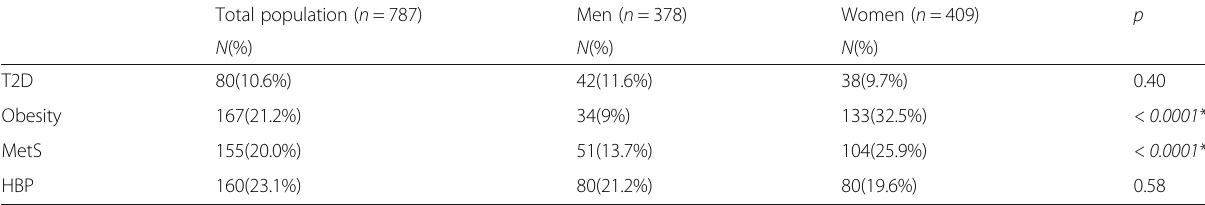
Table 3 Prevalence of the metabolic syndrome and its components in the ISOR population